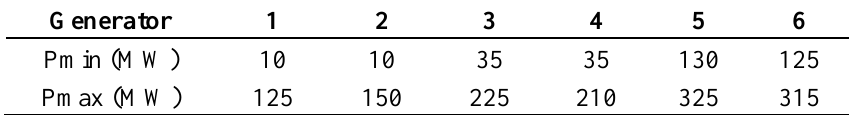
Table 1. Generator active power limits.